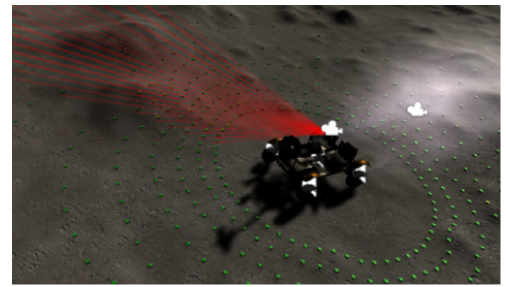
Figure 9. Virtual sensor development rendering.